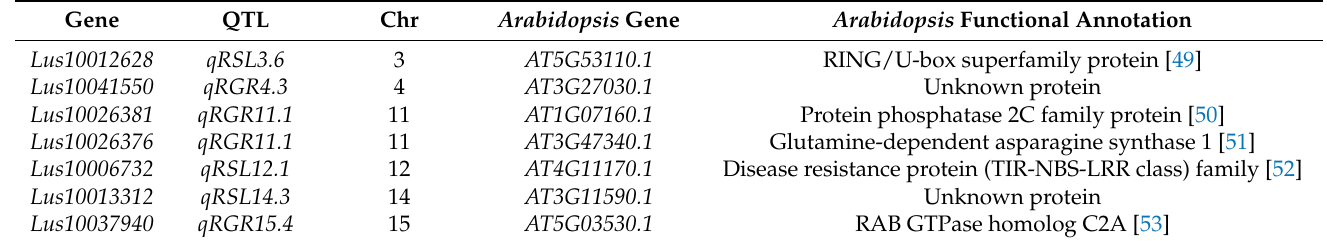
Table 2. Seven genes consistent with the transcriptome genes with salt stress reported